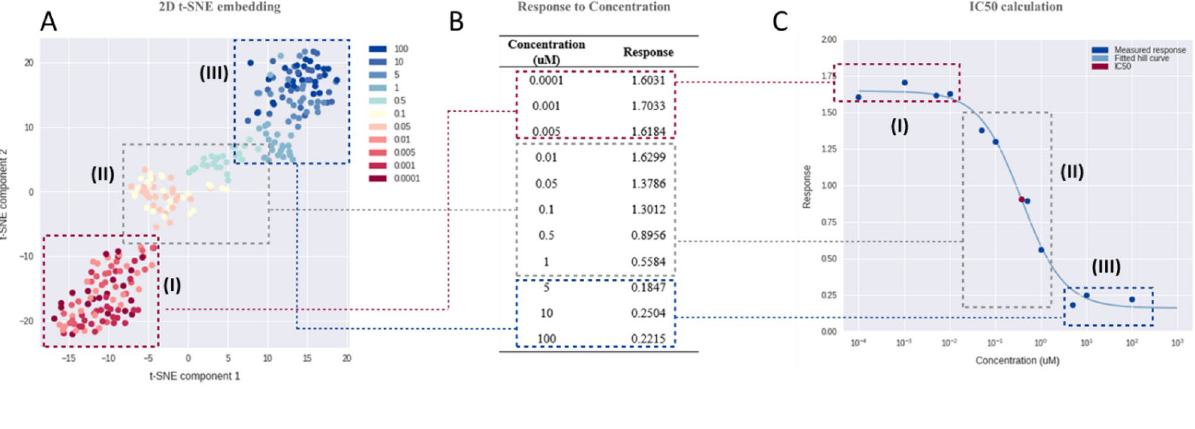
Figure 4. Feature visualization learned by MobileNetV2 for the entire dataset. ( A ) 1028-dimensional features of A549 cell images were projected to a 2D surface using t-SNE, and colored according to drug concentrations. ( B ) Responses to drug concentrations (OD 450 nm ). ( C ) Hill curve drawn using the concentrations and the response in ( B ). The image features of the top (I), slope (II), and bottom regions (III) of the Hill curve ( C ) are clustered in different sections of ( A ). The response values from the images in the slope region (II) increase according to the concentration, which is clearly reflected by the feature visualization ( A the local structure of the high-dimensional input space. OD 450 nm measured by cell proliferation assay according to the DOX concentration in Fig. 4B represents the concentration-dependent drug responsiveness, which was fitted by a sigmoidal curve generated by the Hill equation (Fig. 4C). Based on the Hill curve in Fig. 4C, the IC50 concentration was determined for the concentration at which 50% cell viability was observed compared to that of control cells. Features from cell images corresponding to each concentration formed three clusters after trans- formation by t-SNE (I, II, and III in Fig. 4A), which were largely divided in the Hill curve into top (I), slope (II), and bottom (III) regions in Fig. 4C. The results implied that numerical values of cell viability by visual inspection of cell images could be learned, and that the trained model predicted cell viability in continuous numbers linked to cell images. Another visualization technique is to reveal the localization of discriminative regions for decisions in an input image. Google explainable AI was utilized to understand how our trained model predicted drug responsiveness from cell images. The XRAI option of explainable AI was used to display attributions, which was highlighted in accordance with the prominent image features that were impactful in the model rather than the individual pixels. XRAI highlights the most influential regions in yellow and the least influential in blue, based on the